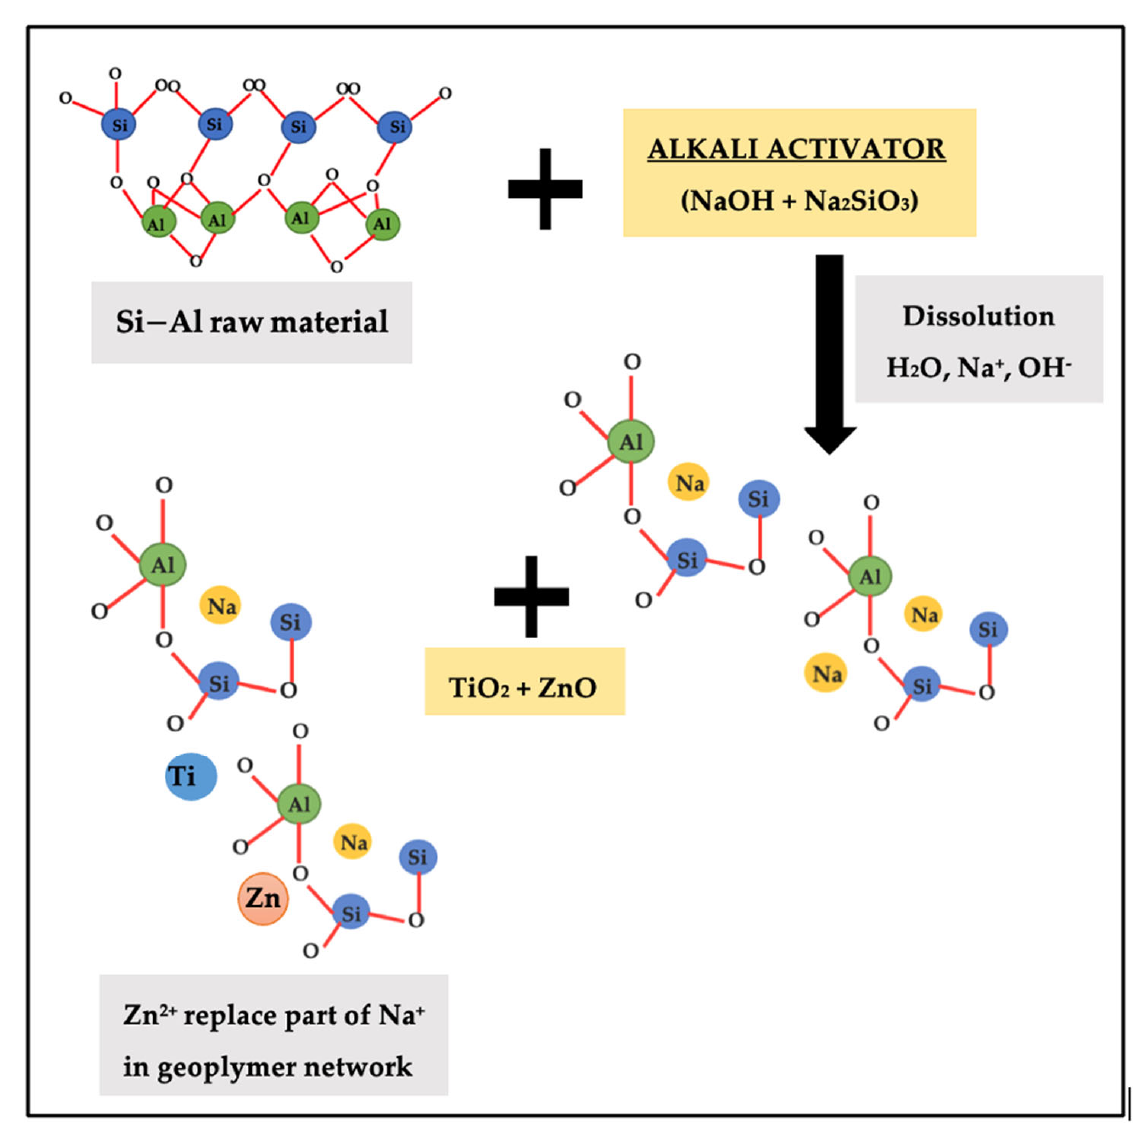
Figure 6. Schematic diagram of mechanism reaction between ZnO and geopolymer.